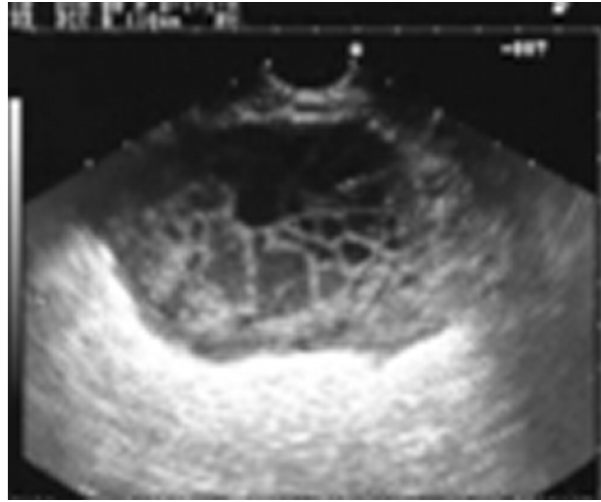
Figure 3 - Endoscopic ultrasonography showing debris in the fluid collection.